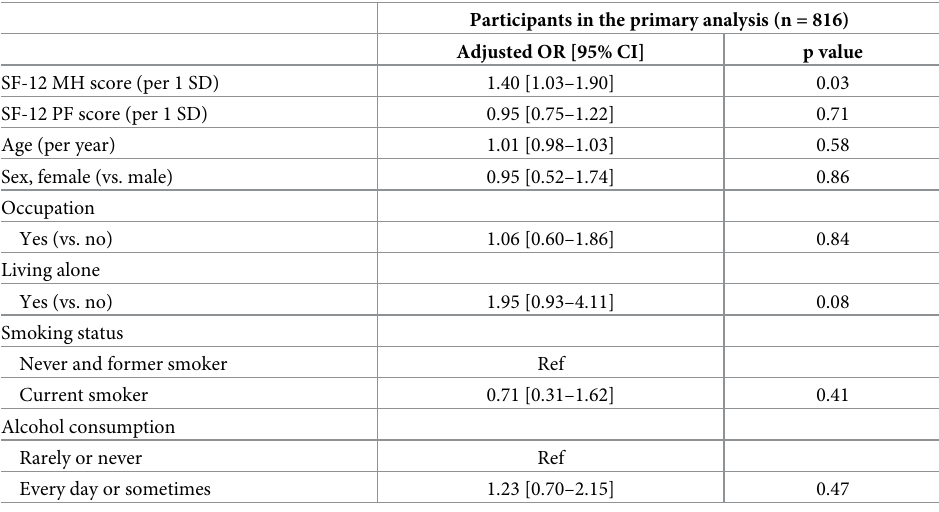
Table 4. Primary analysis adjusted odds ratios for antibiotic